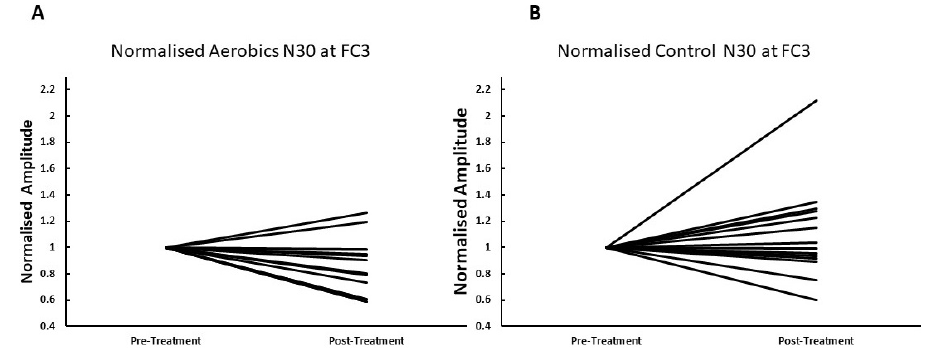
Figure 2. The graphs show individual changes in somatosensory-evoked potential (SEP) normalized peak amplitudes pre and post the aerobic exercise intervention ( A ) and pre and post the control intervention ( B ) analyzed from the FC3 channel. Significance was set at p < 0.05 for all tests. Note most participants’ N30 SEP peak amplitudes decreased post-exercise, while most individuals did not change after the control